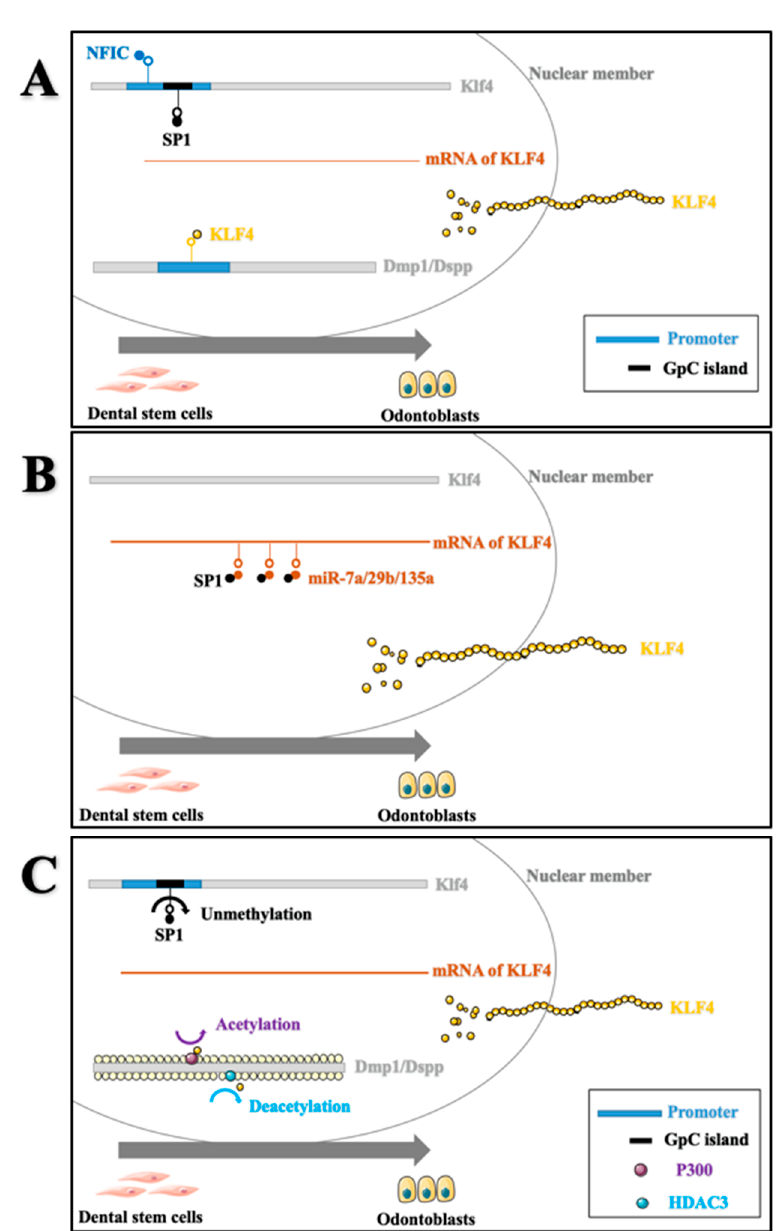
Figure 3. Transcriptional ( A ), posttranscriptional ( B ), and epigenetic ( C ) regulation of KLF4 in DPSCs. KLF4 could directly upregulate the expression levels of Dmp1 and Dspp by binding to their promoters; similarly, NFIC and SP1 could regulate KLF4 expression by binding to the promoter region of Klf4. Sp1 was able to function as a ceRNA of Klf4 as well. Demethylation of the SP1/KLF4 binding motif enhanced the efficiency of SP1 binding and transcriptional regulation of KLF4. Additionally, KLF4 could recruit the histone acetylases P300 and HDAC3 to transactivate the expression of Dmp1 and Sp7. Complicated regulatory networks among the Sp1/Klf4/Dmp1, Sp1/Klf4/Dspp, and Sp1/Klf4/Sp7 axes need further investigation.